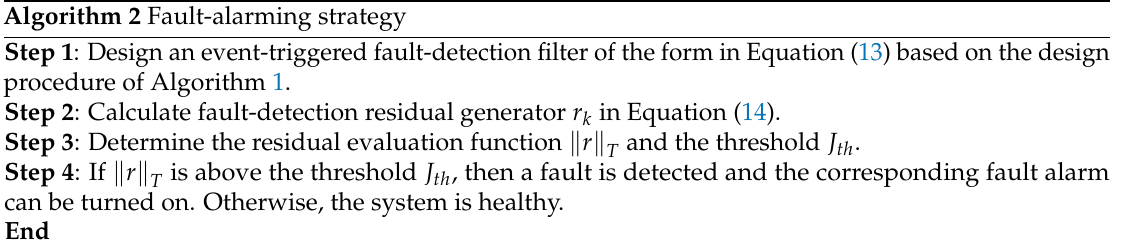
Algorithm 2 Fault-alarming